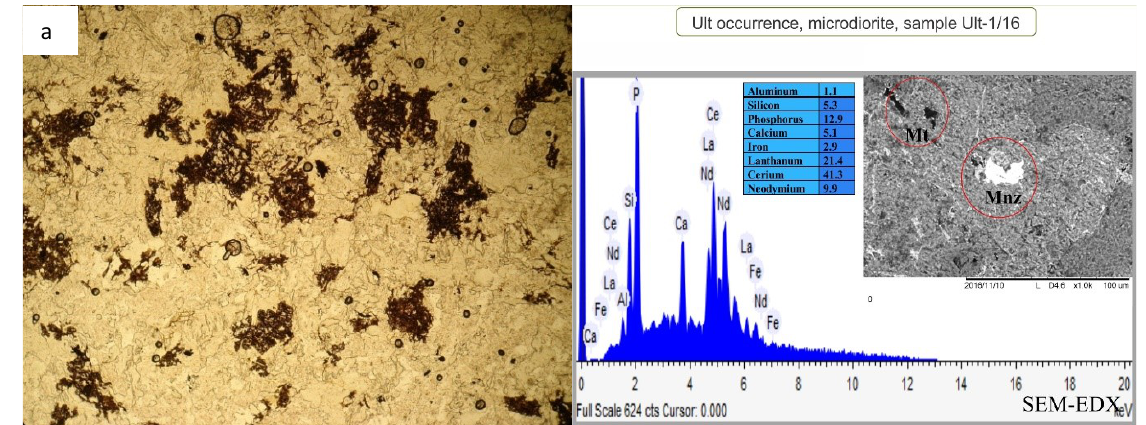
Figure 4. Metasomatized microdiorite sample Ult-1/16, magnification 40х ( a). SEM-EDX- electron images, where Mn - and Mnz – monazite